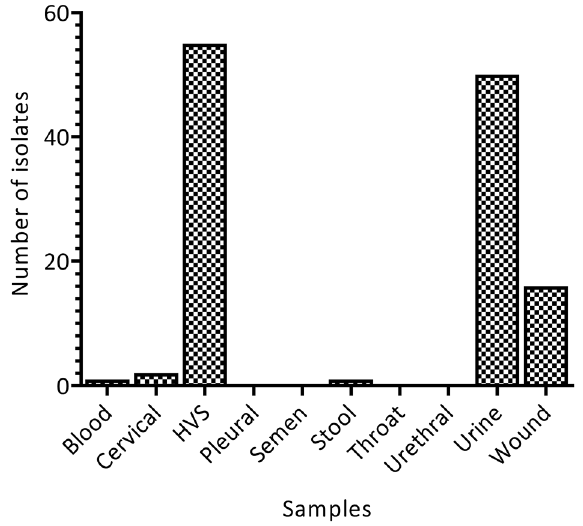
Figure 2. Distribution of different clinical isolates among the various samples.